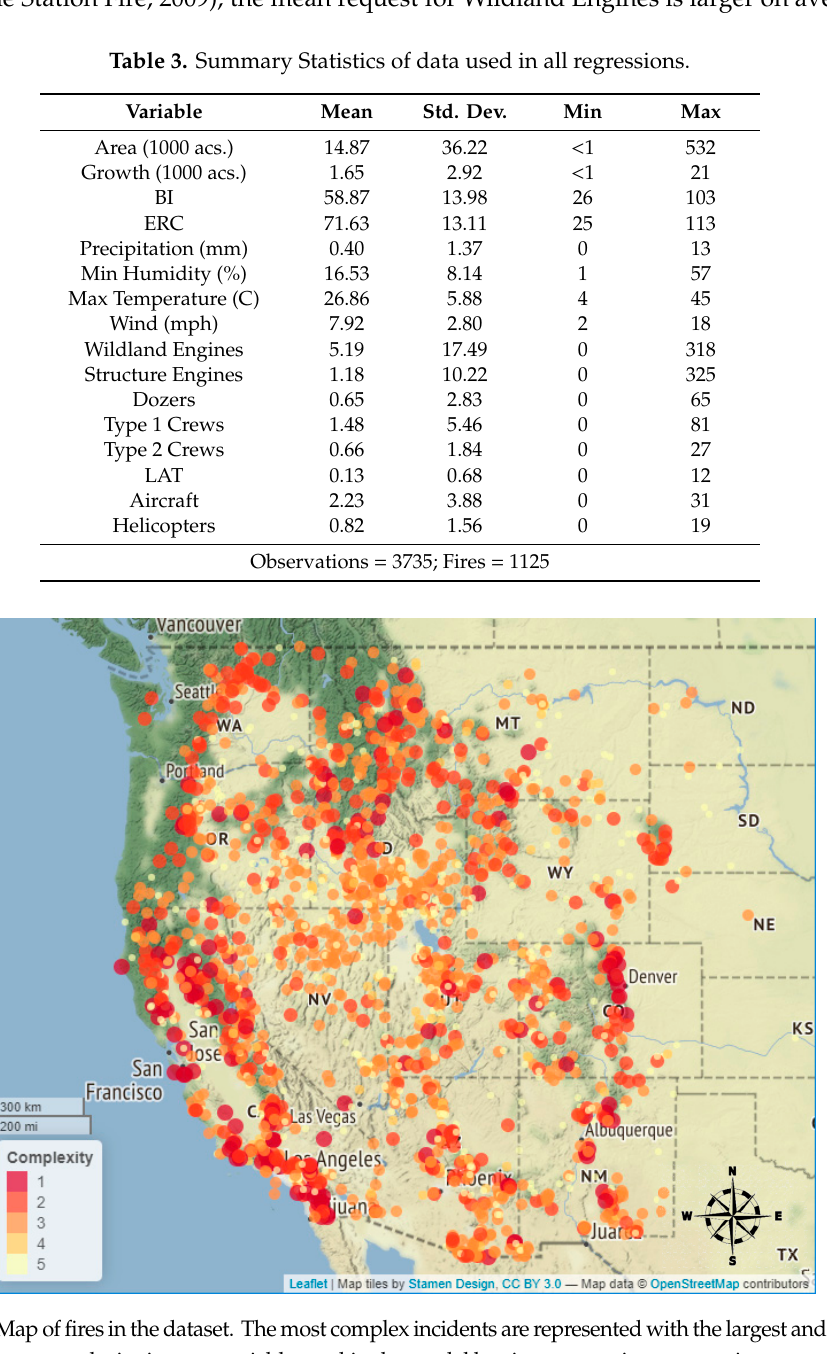
Figure 2. Map of fires in the dataset. The most complex incidents are represented with the largest and darkest dots. Incident complexity is not a variable used in the model but is a composite measure incorporating fire size and values at risk. An interactive version of the map is in the Supplementary Materials.